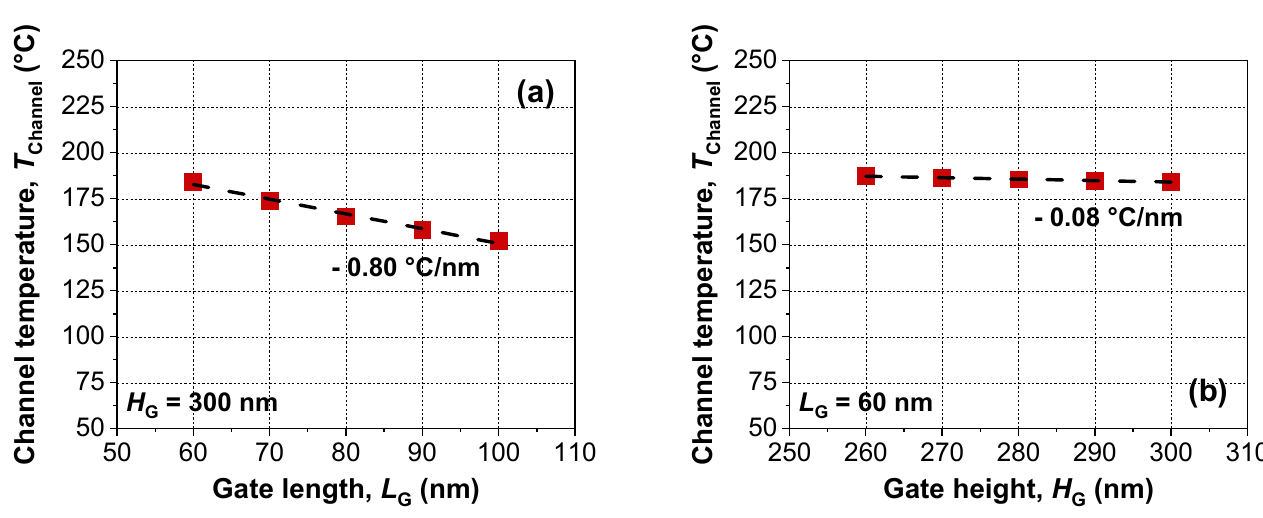
bias conditions with V G = 0.5 V, V S . = 0 V, and V D = 6 V. ( b ) Extracted temperature of the device along